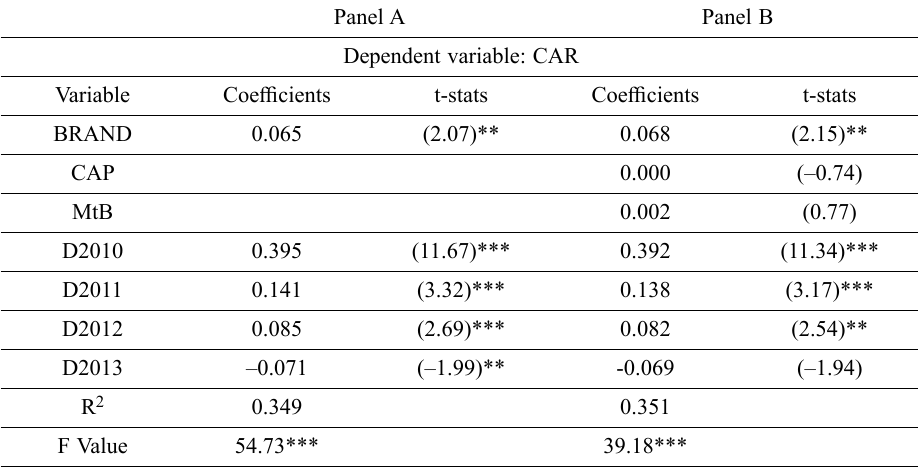
Table 2. Regression results for the impact of being in Top 100 brands list in